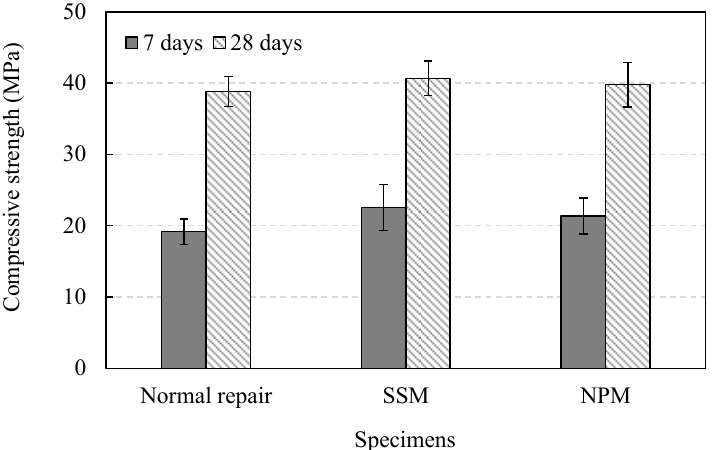
Figure 7. Compressive strength development of bio-coating materials.